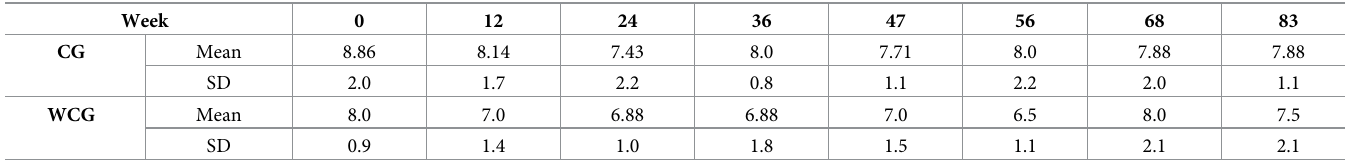
Table 1. SDMA concentration ( μ g/dl) of the dogs in the Control Group (CG) a and Weight-Change Group (WCG) over time. Week